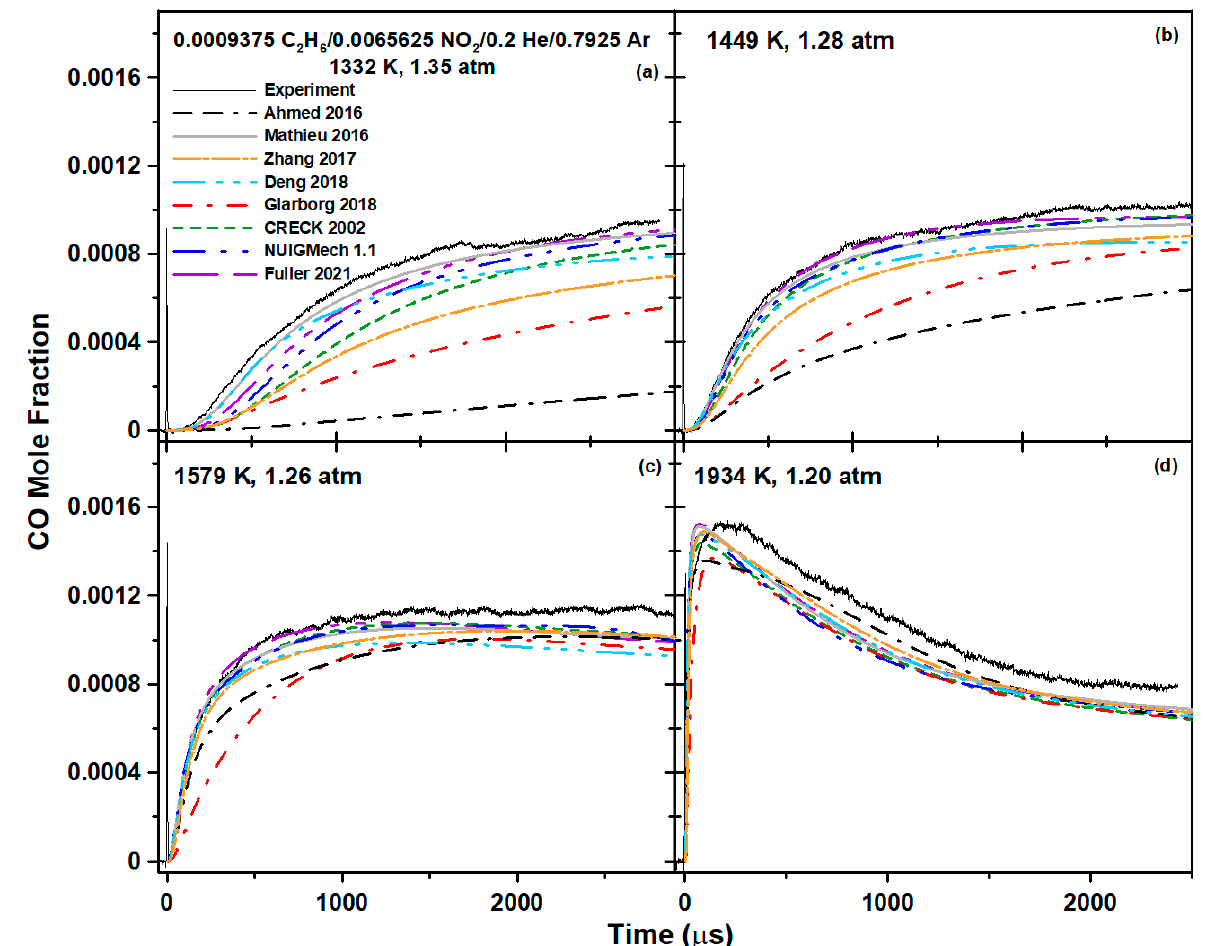
Figure 7. Comparison between experimental CO profiles and predictions of detailed kinetics models from the literature for a 0.0009375 C 2 H 6 /0.006 NO 2 /0.2 He/0.7925 Ar mixture at around 1.2 atm and for various temperatures: ( a ) 1332 K, ( b ) 1449 K, ( c ) 1579 K, and ( d ) 1934 K.